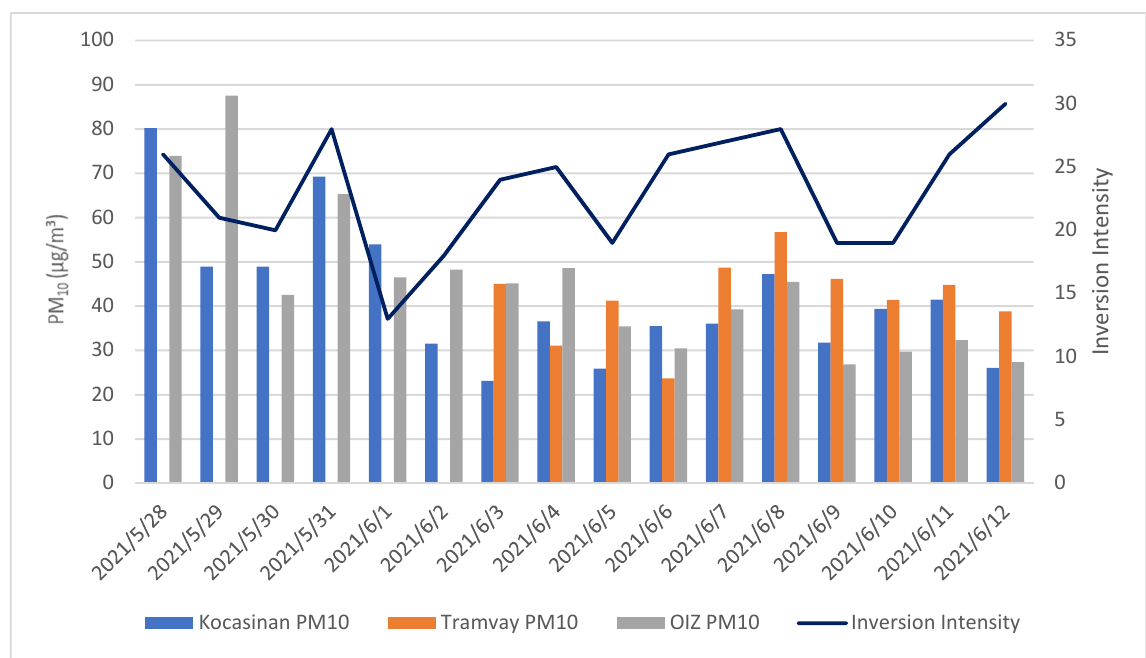
Figure 4. PM 10 daily concentrations at Kayseri sampling points and inversion intensity (autumn/winter period).